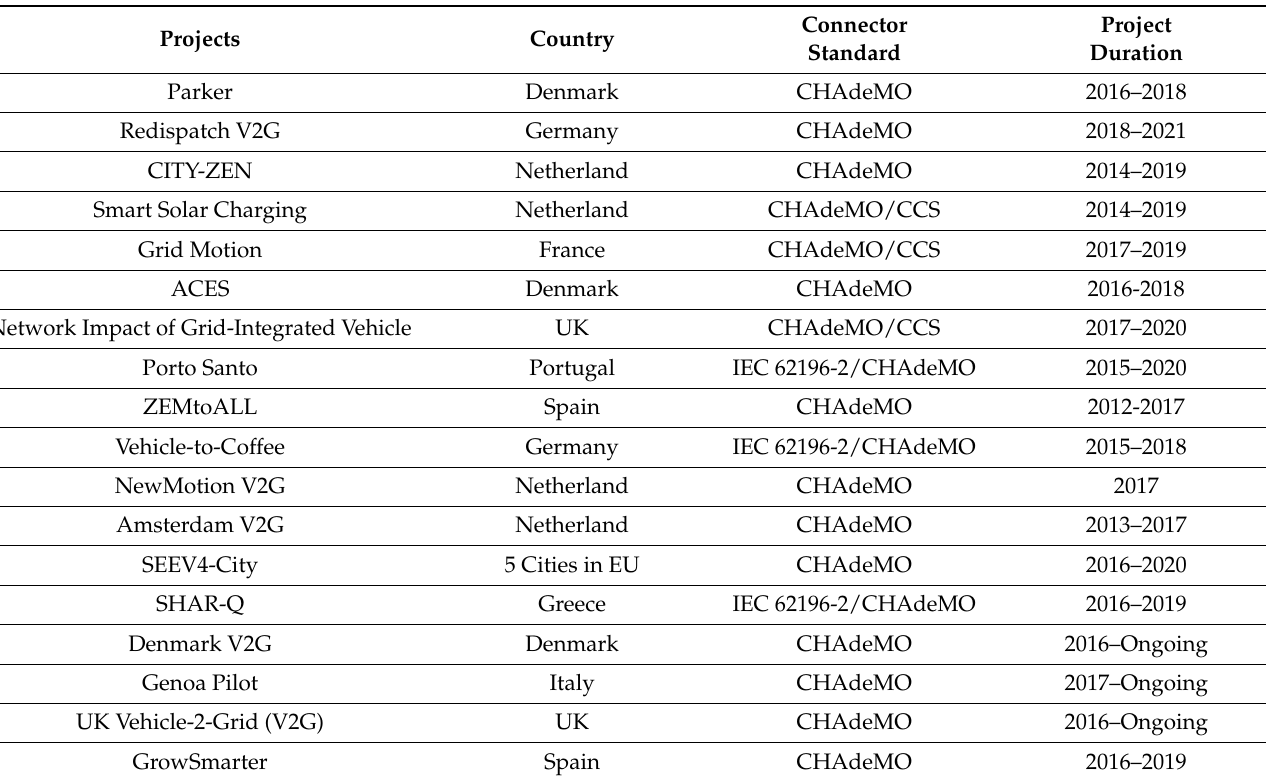
Table 1. European V2G test projects with corresponding connector standards